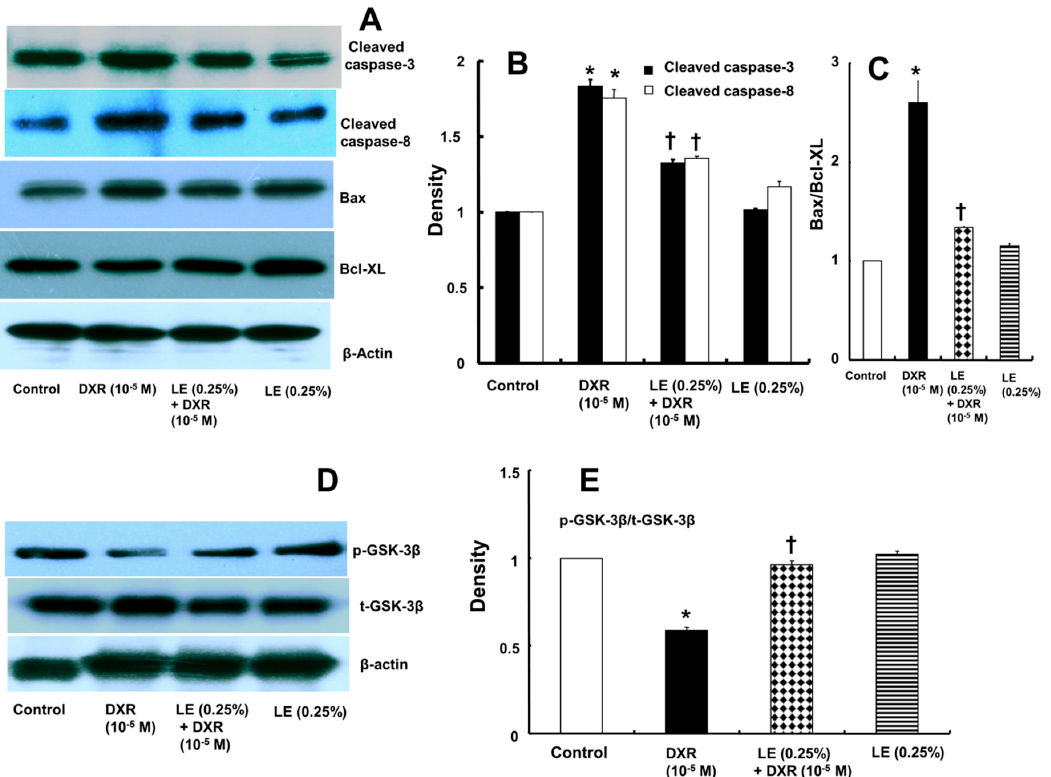
Figure 3. ( A – C ): Effects of Intralipid ® (lipid emulsion, LE; N = 3) on doxorubicin (DXR)-induced cleaved caspase-3, cleaved caspase-8, Bax, and Bcl-XL protein levels in H9c2 rat cardiomyoblasts. Cells were treated with DXR (10 − 5 M) for 6 h, LE (0.25%) for 1 h followed by DXR (10 − 5 M) for 6 h, or